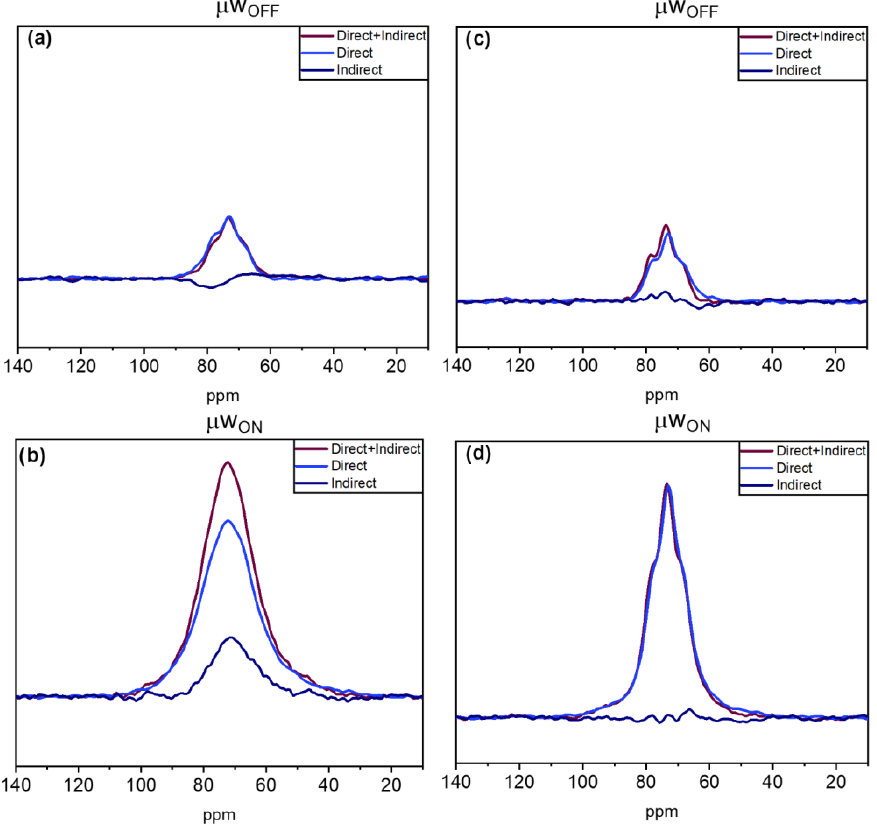
Figure 8. 13 C MAS spectra obtained at a build-up time of 300 s for biradical 3 ( a ) without microwave irradiation (µW OFF ), ( b ) with microwave irradiation (µW ON ), and for biradical 4 ( c ) without mi- crowave irradiation (µW OFF ), and ( d ) with microwave irradiation (µW ON ). Spectra were recorded at nominal 115 K. Note: The 13 C MAS spectra showing the direct and indirect pathway were recorded with a saturation recovery sequence in the 13 C channel. The spectra depicting only the direct pathway were recorded with a saturation recovery sequence in the 13 C channel where during the build-up time, rotor-synchronized 180° pulses were applied to the 1 H channel. The spectra showing only the indirect pathway denote difference spectra of the two other respective ones.